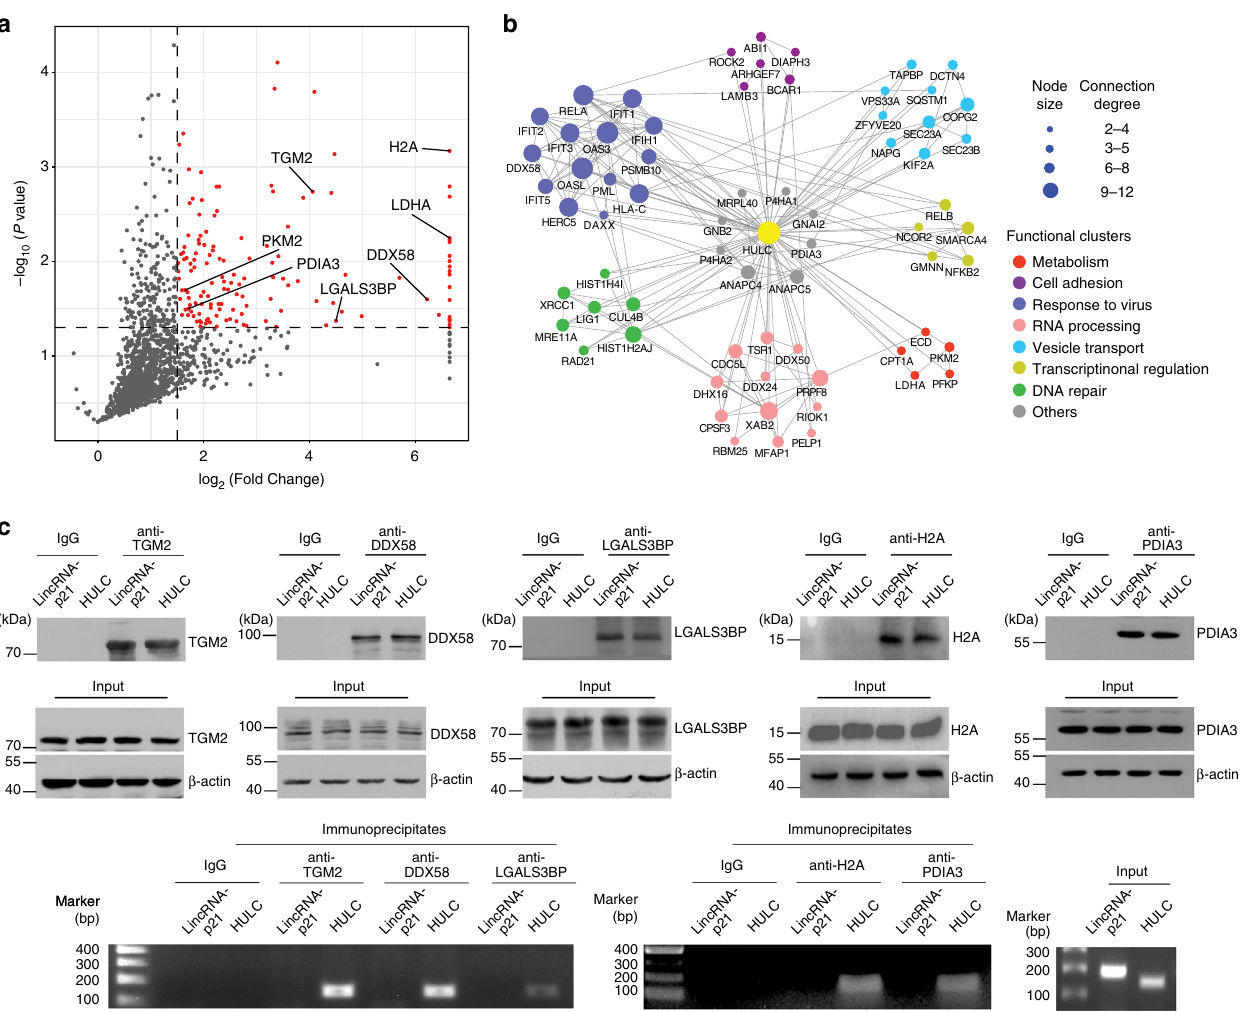
Fig. 2 The identi fi ed HULC interacting proteins. a The volcano plot of the identi fi ed proteins. The proteins signi fi cantly enriched in the tobramycin puri fi ed samples are shown as red dots. Log 2 fold change was plotted on the x -axis and − log 10 P value was plotted on the y -axis. b The protein interactome network of HULC. PPI information was obtained through a database search using String 9.0 and imported into Cytoscape 3.1.1 for network construction. Proteins and their interactions are shown as nodes and edges. Node size re fl ects the interaction degree. Proteins are grouped based on their known biological functions. c Validation of selected identi fi ed proteins by RIP. Immunoblots of TGM2, DDX58, LGALS3BP, H2A and PDIA3 in the cell lysates and immunoprecipitates are shown in the upper panel. The agarose gel electrophoresis images of HULC ampli fi ed by qRT-PCR are shown in the lower panel. LincRNA-p21 was used as an irrelevant lncRNA control. See also Supplementary Figs. 2 and 3. Source data are provided as a Source Data fi